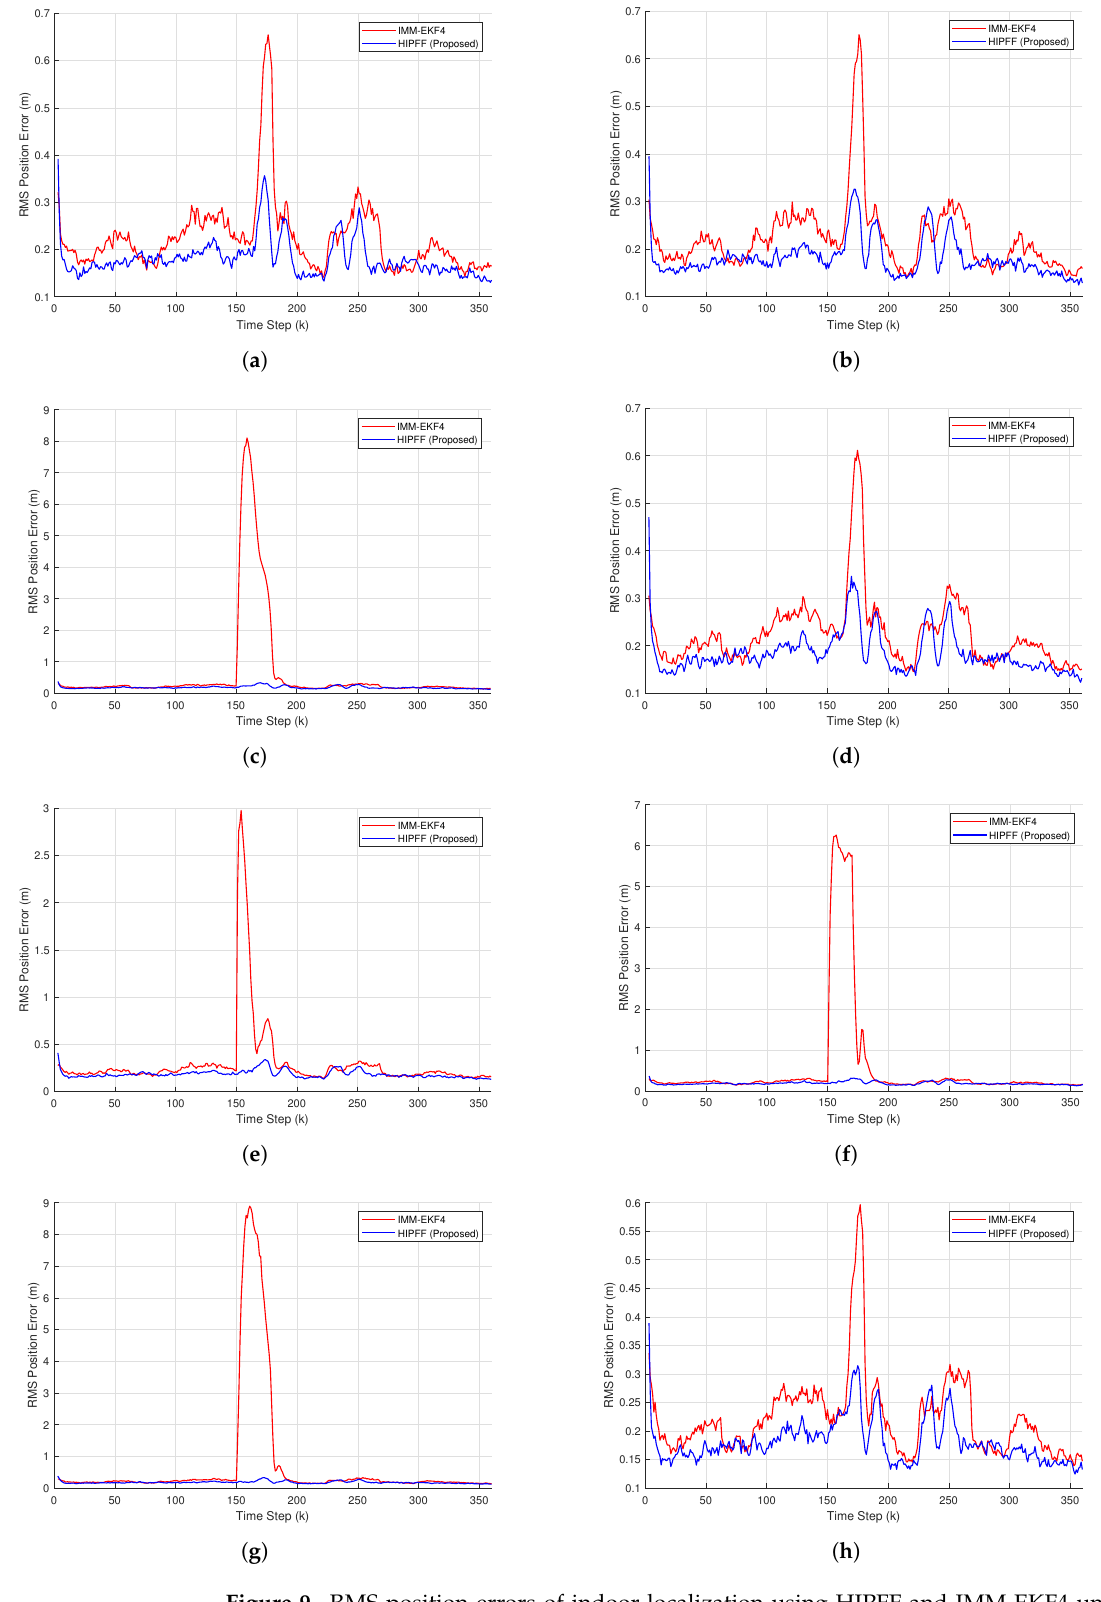
Figure 9. RMS position errors of indoor localization using HIPFF and IMM-EKF4 under NLOS conditions in which the AN (AN) in an NLOS situation was ( a ) AN1, ( b ) AN2, ( c ) AN3, ( d ) AN4, ( e ) AN5, ( f ) AN6, ( g ) AN7 and ( h )